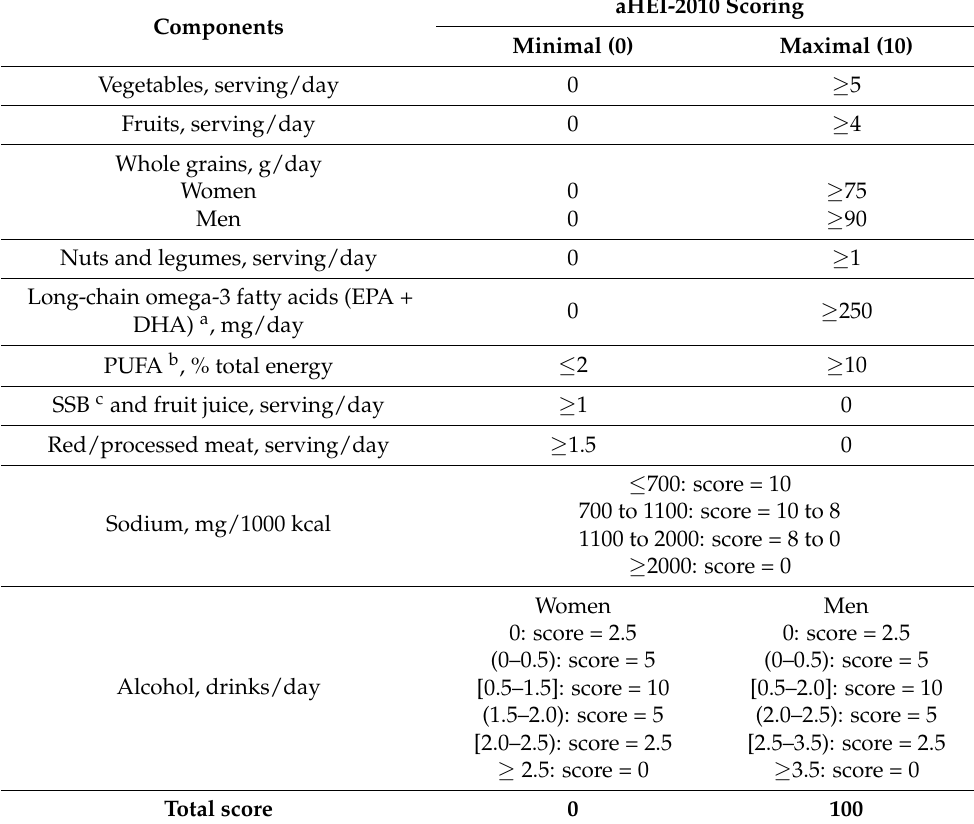
Table 1. Components and criteria for scoring the alternate Healthy Eating Index 2010 (aHEI- 2010).